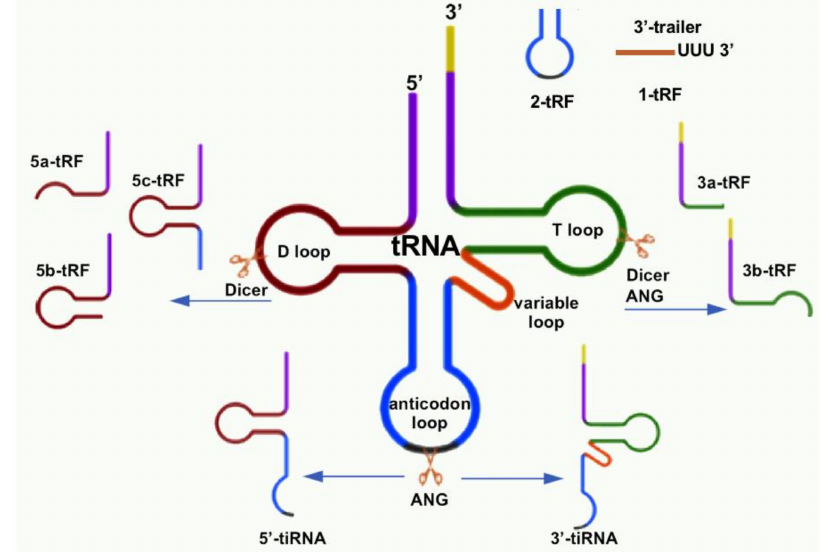
Figure 2. The types of tsRNAs are classified by size and sequence location in the tRNA structure. 1-tRNA-derived fragment (tRF) is generated by RNase Z, which cleaves 3 (cid:48) trailer from pre-ribosomal RNA (rRNA). 2-tRF, which contains the anticodon loop, is generated by unknown ribonuclease. In the case of 3-tRFs and 5-tRFs, the subtypes are determined by size and location of the source. tiRNAs are grouped by whether their source sequences are from the 5 (cid:48) or 3 (cid:48) tRNA cleaved by angiogenin